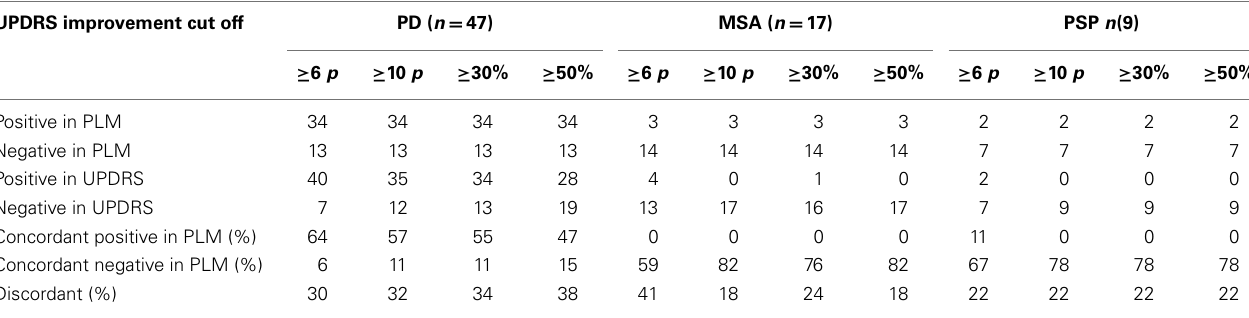
Table 5 | L -DOPA responses with the two measuring